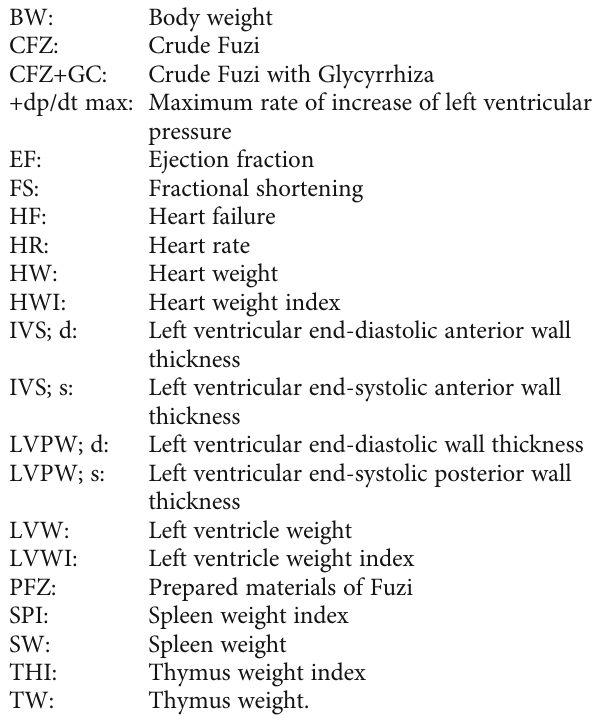
SI Table 1: chemical information for identi fi ed compounds of CFZ. SI Table 2: chemical information for identi fi ed compounds of CFZ+GC. (Supplementary